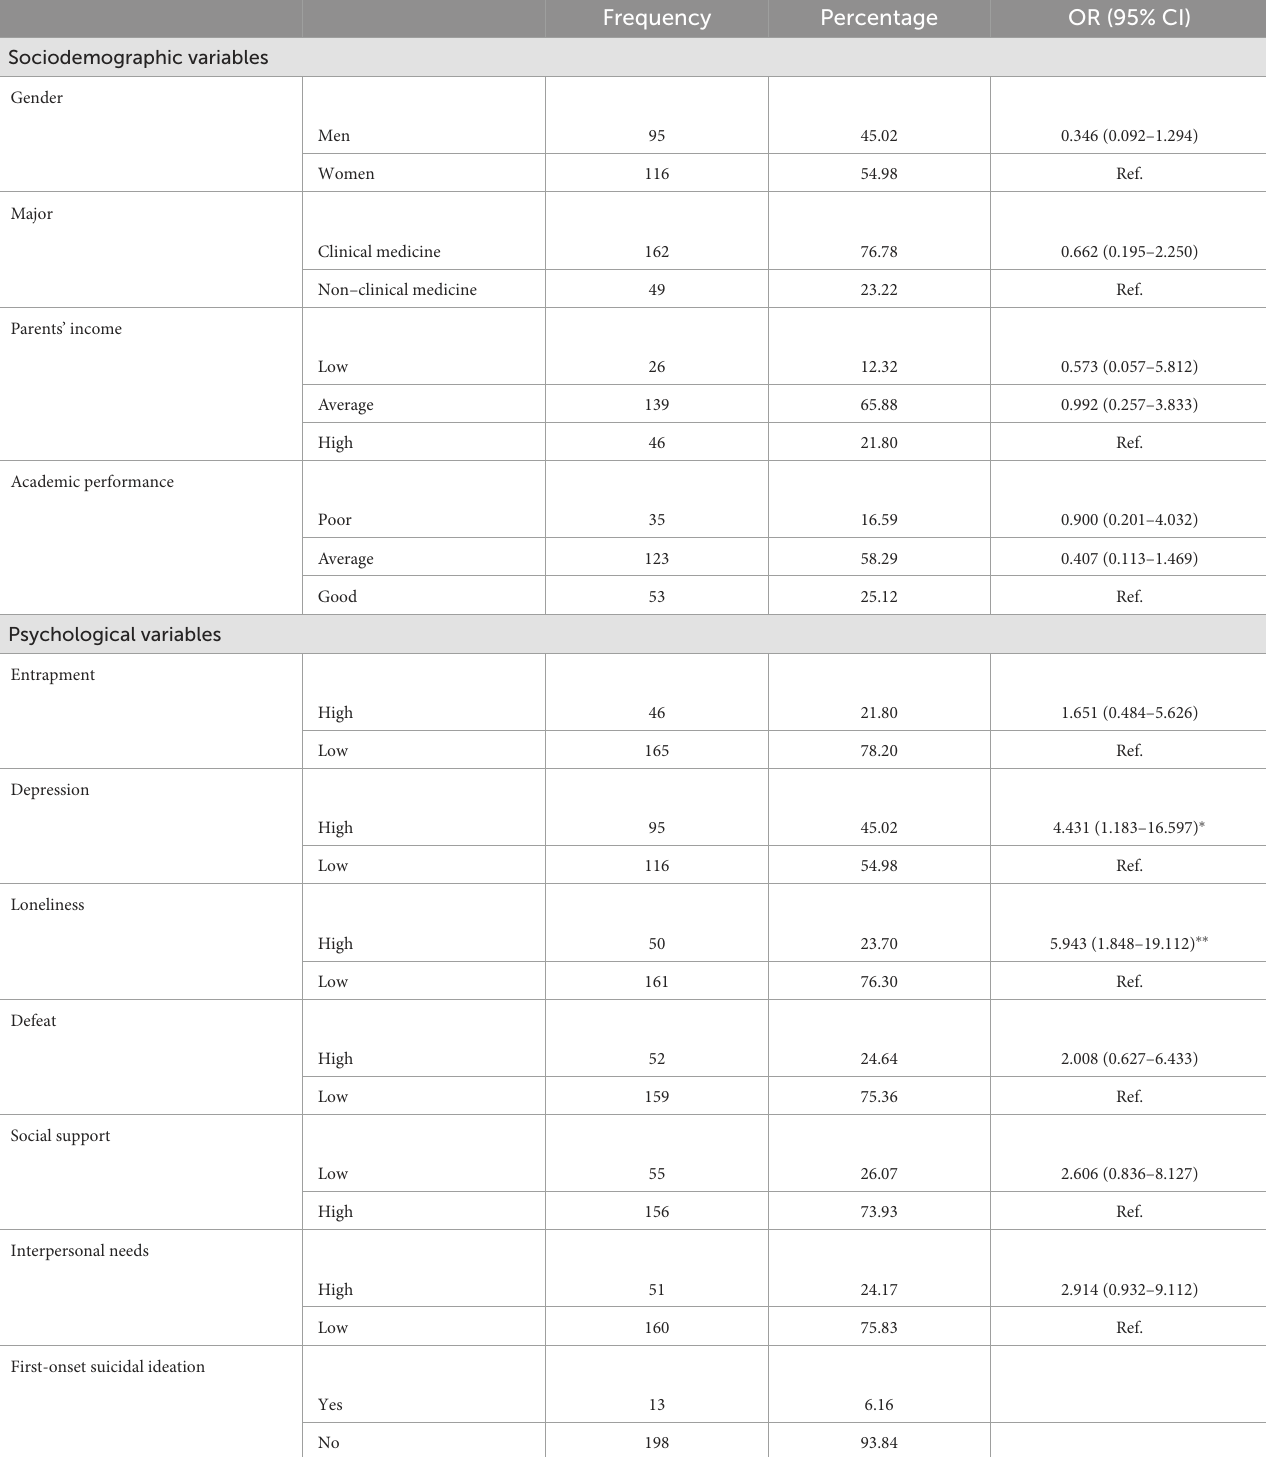
TABLE 1 Sociodemographic and psychological variables associated with suicidal